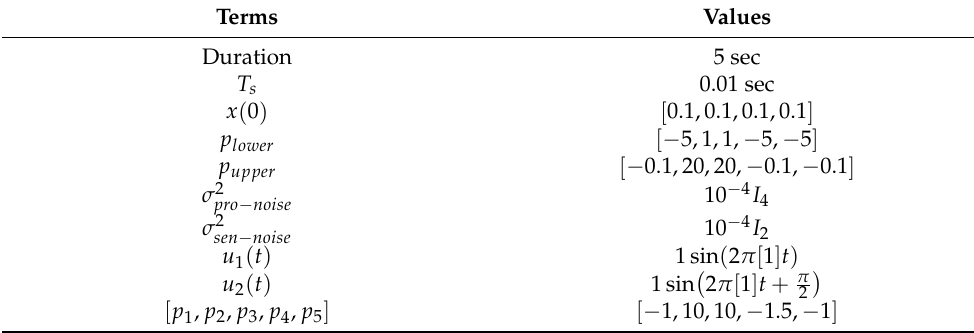
Table 4. Simulation